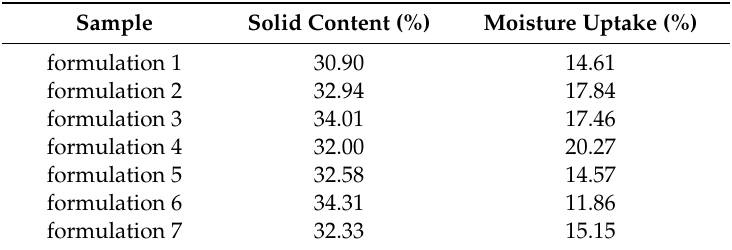
Figure 5. SEM images of cured adhesives. Table 3. The solid content and moisture uptake of investigated